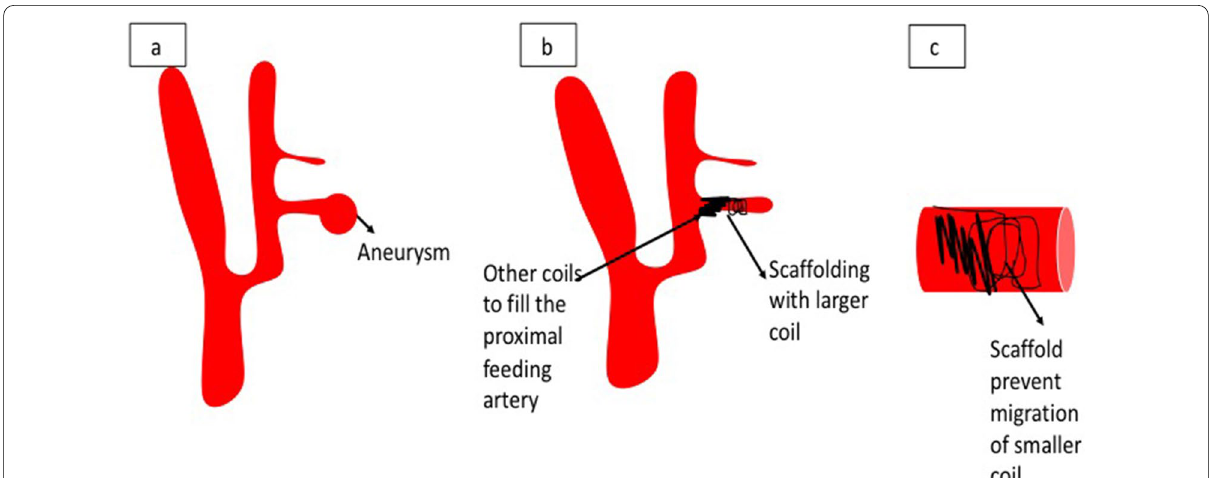
Fig. 2 Graphical representation of scaffolding technique ( a ) representative comparable image with Fig. 1d–f, and shows aneurysm from side branch of external carotid artery. b 3D scaffold of large coil in the artery is made and subsequently other coils are placed proximal to it ( c ) enlarged graphical representative image of ( b ) shows close up of scaffolding technique